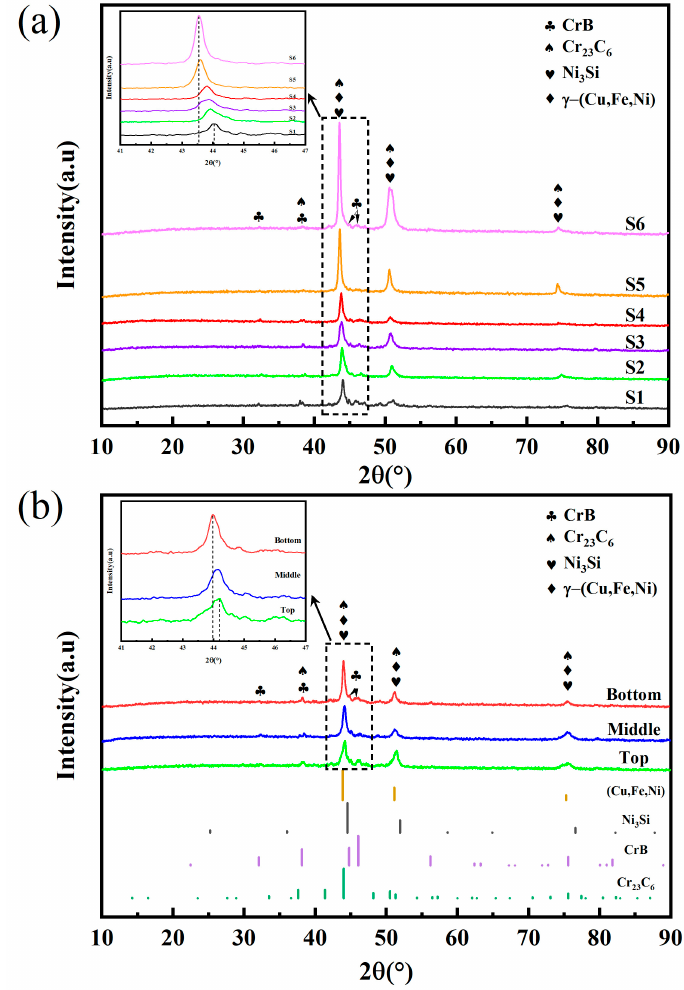
Figure 7. X-ray diffraction patterns of the Ni60A coating: ( a ) S1–S6, ( b ) different parts in the S2.